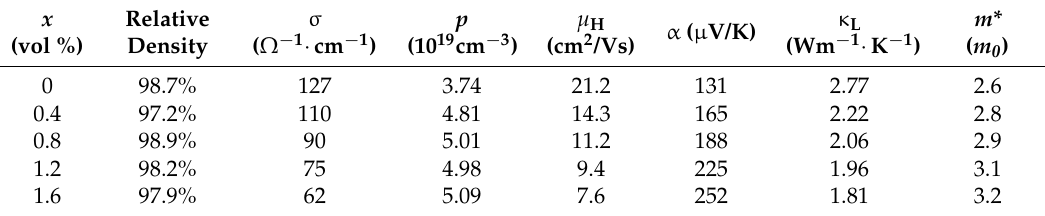
Figure 7. Temperature dependence of electrical conductivity ( σ ) of C 60 /Cu 2 SnSe 3 composites. Table 1. Chemical composition, some physical and structural parameters of x C 60 /Cu 2 SnSe 3 composites at room